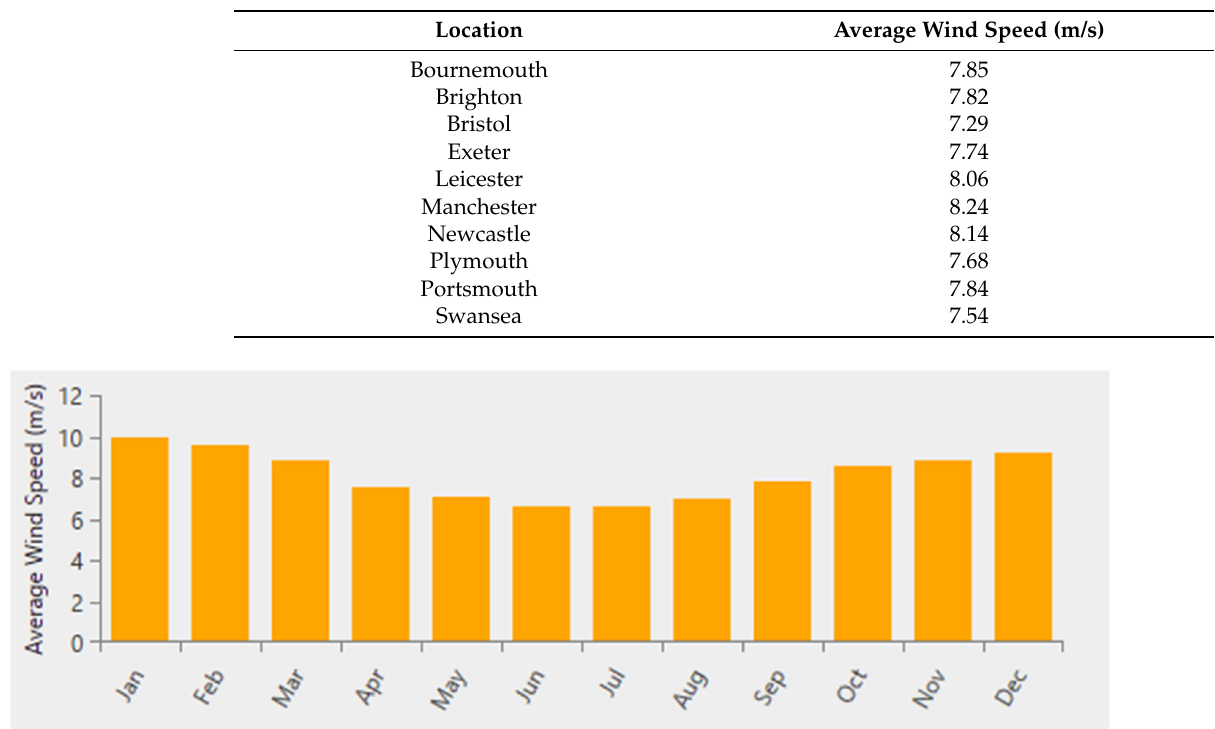
Table 4. Wind resource at each location.